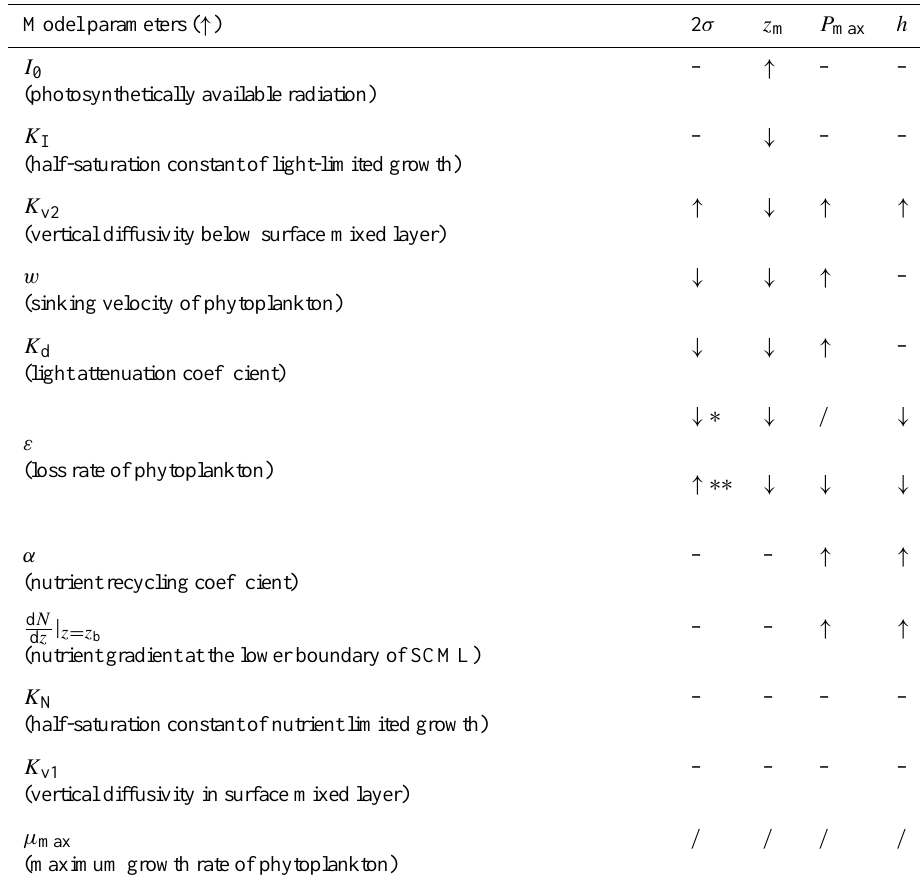
Table 1. Influences of dynamic model parameters on the steady-state SCML thickness (2 σ) , depth ( z m ), intensity ( P max ), and the total Chl a in the water column ( h